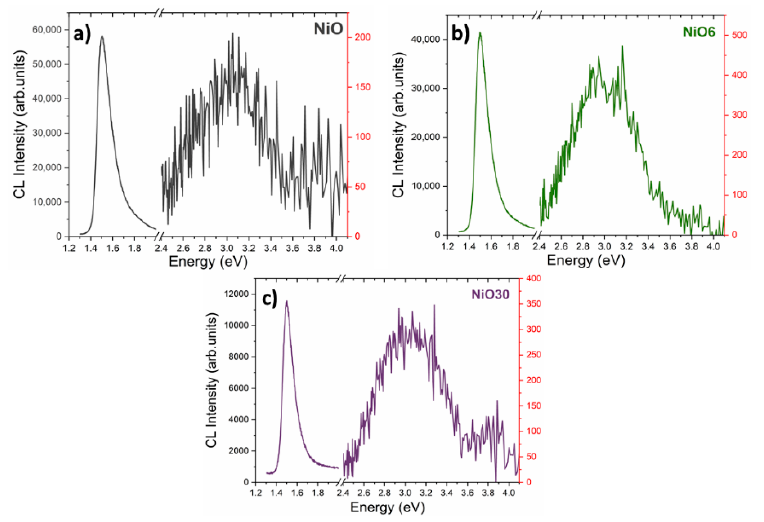
Figure 8. Cathodoluminescence (CL) spectra acquired at room temperature from ( a ) NiO, ( b ) NiO6 and ( c ) NiO30 samples.